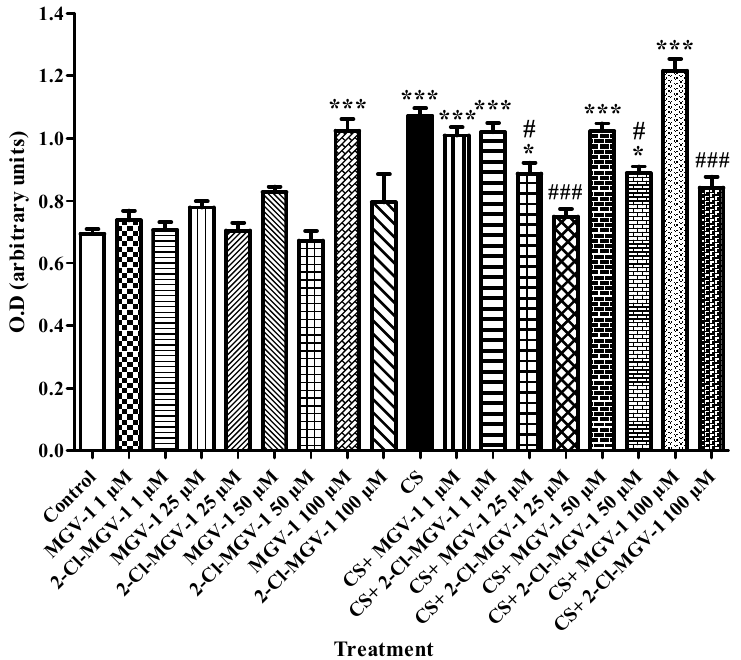
Figure 1. Dose-response analysis of TSPO ligands against CS-induced cytotoxicity in H1299 lung cancer cells. Cytotoxicity was measured by assessment of LDH in the medium using ELISA. Cytotoxicity levels were elevated significantly following CS exposure, while levels of superior protection by 2-Cl-MGV-1 were achieved at a concentration of 25 µM ( n = 10 in each group). Results are represented as mean ± SEM. * p < 0.05 and *** p < 0.001 vs. control; # p < 0.05 and ### p < 0.001 vs. CS. CS = cigarette smoke.